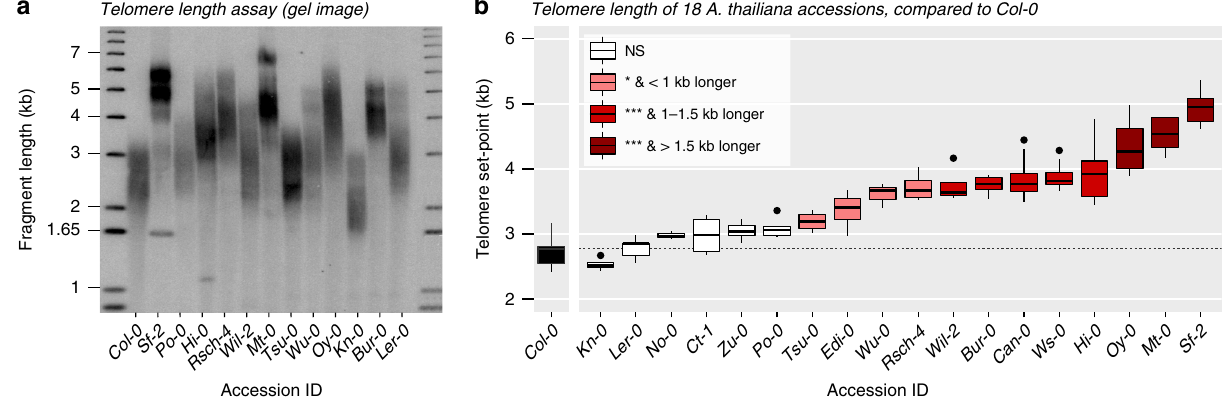
Fig. 1 Parental genotypes of the Arabidopsis MAGIC population display different telomere length set points. a A representative TRF southern blot of genomic DNA from Arabidopsis accessions (genotypes). b Between 4 and 17 individual plants were analyzed for each accession. The mean telomere length distribution of each genotype is shown in boxplots, where the ‘ boxes ’ represent the interquartile range (IQR), the whiskers extend to the largest and smallest observations within 1.5 * IQR and points represent observations outside of the 1.5 * IQR. The boxes are colored by the signi fi cance of a Tukey ’ s HSD test between each parent and the reference genotype, Col-0. Signi fi cance codes: NS: P > 0.05, * P ≥ 0.005, *** P